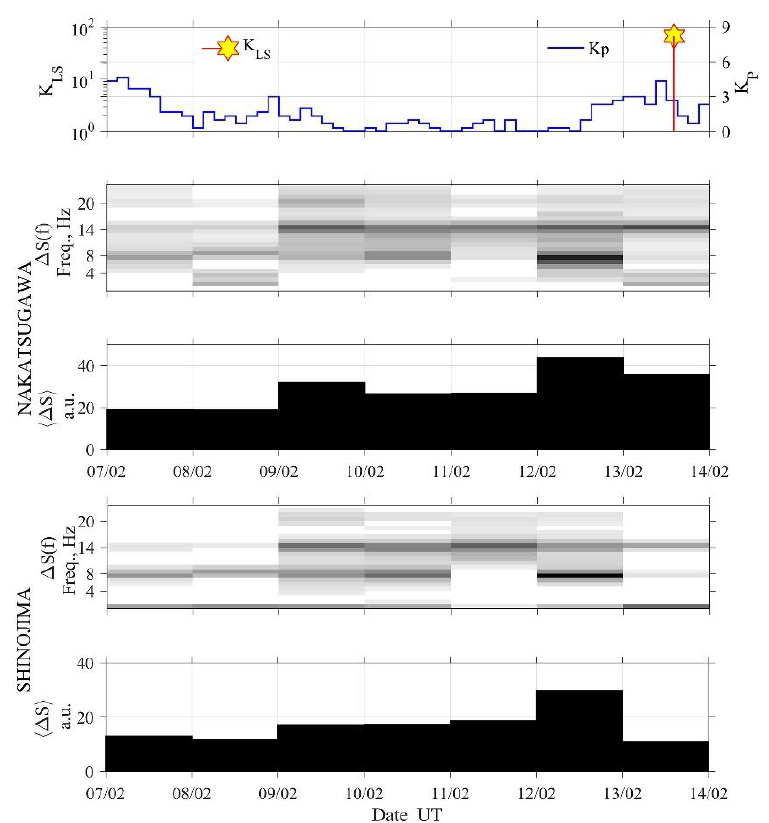
Figure 4. The evolution of seismicity, geomagnetic activity, and parameter of ULF/ELF magnetic field radiation over the interval of 7–14 February 2021 for the first EQ. The top panel shows evolutions of seismicity K LS and geomagnetic activity Kp. The next panels display spectra and their daily maximum values observed in NAK (second and third panels) and SHI (fourth and fifth panels).